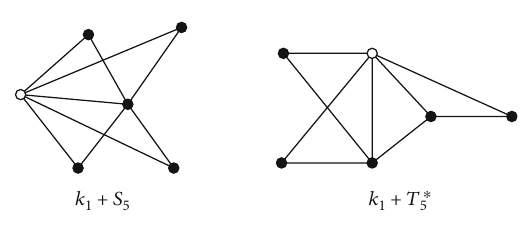
Figure 4: 1-apex tree.